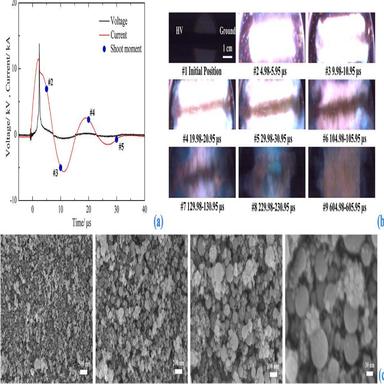
Explosion of an Al-coated carbon foil in free air, waveforms for the circuit current and voltage (a), backlit shadow image (b), and SEM images (c).